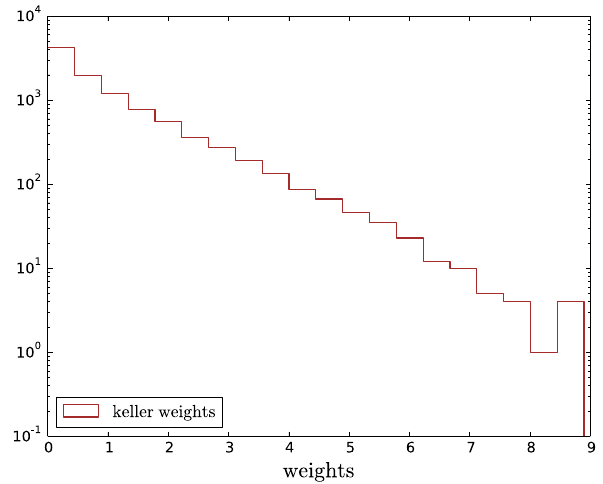
Fig. 17 Weight distribution after reweighting using rapidity distribu- tions of charged leptons from CMS W ± production data